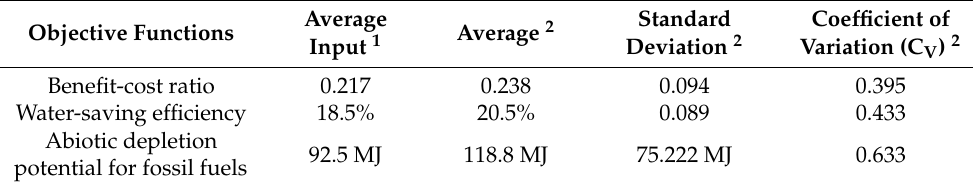
Table 6. Assessment of Monte Carlo simulation results.